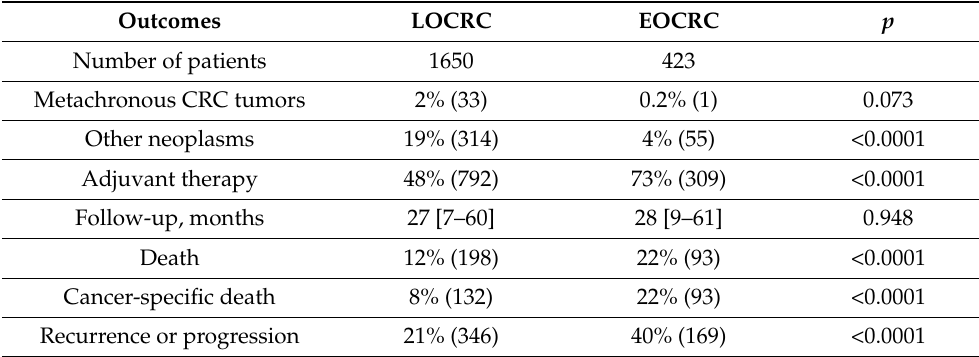
Table 4. Oncological outcomes, median [IQR], and % (n).